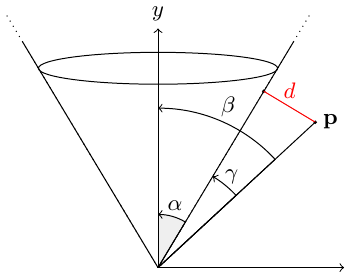
Figure 2: Angles used for calculating the distance to a cone.